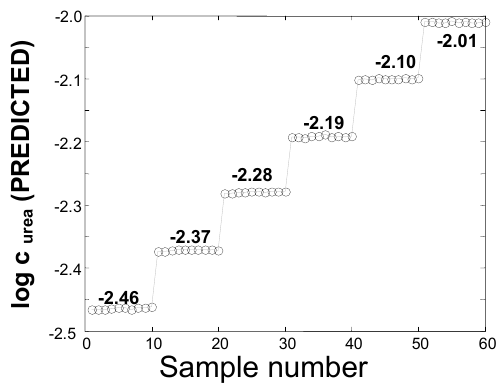
Figure 4. Predicted responses of bioelectronic tongue in the case of dialysis fluids containing various amounts of urea (With kind permission from Springer Science+Business Media: Microchim)